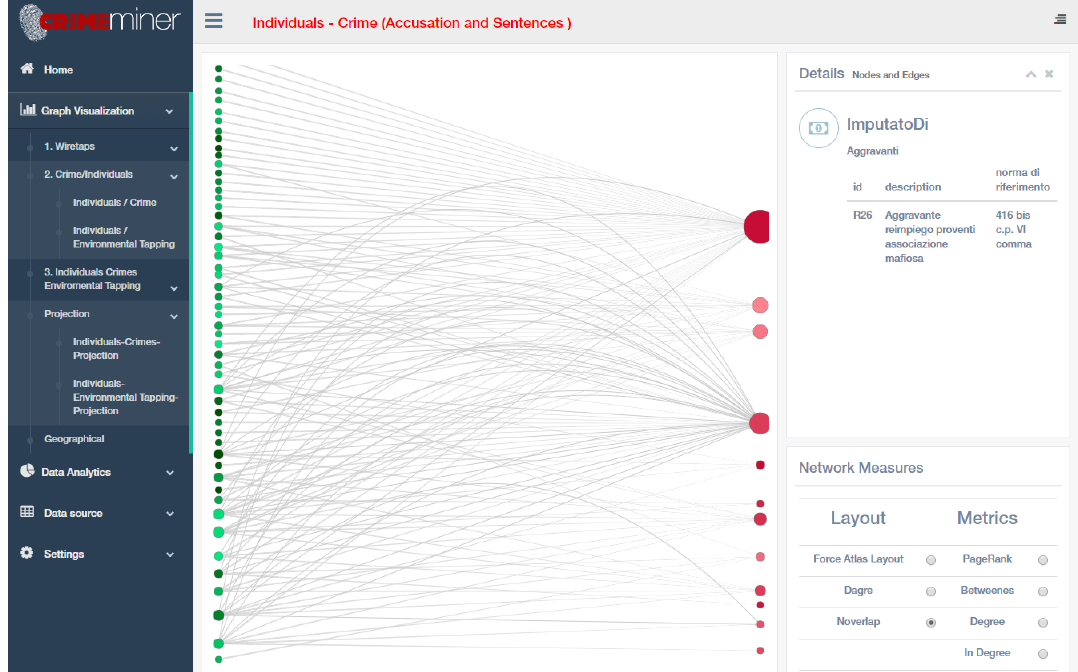
Figure 4. Bipartite graph of an individual’s